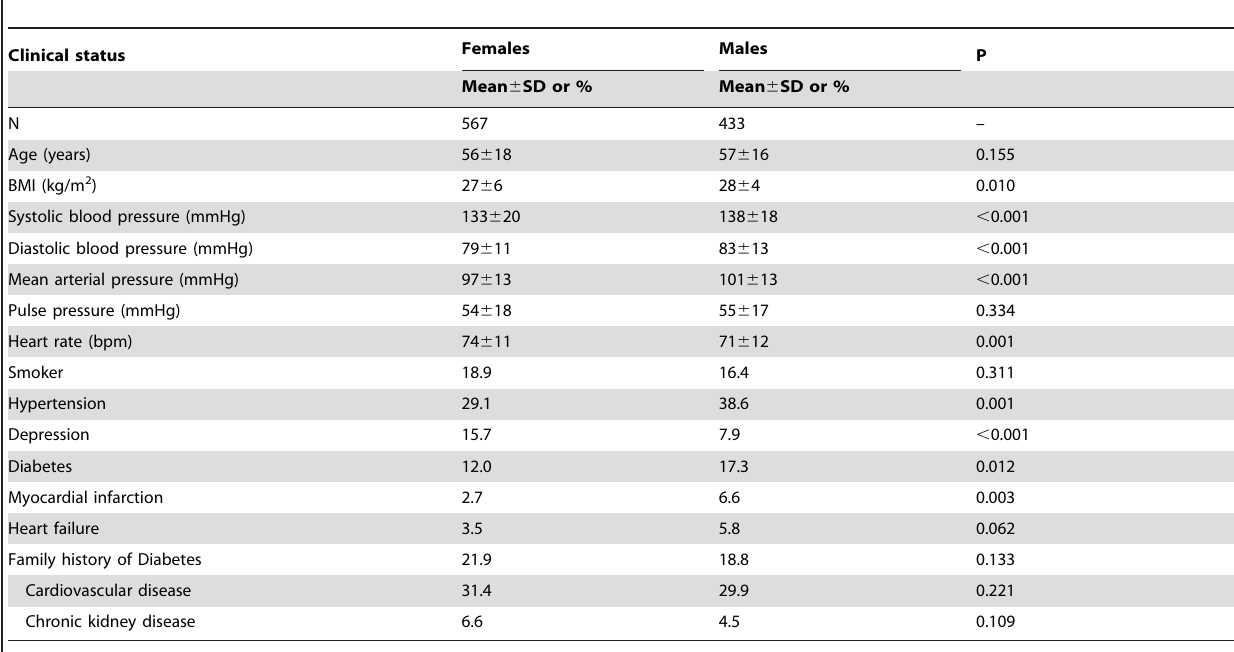
Table 1. Socio-demographic and clinical characteristics of the study population according to